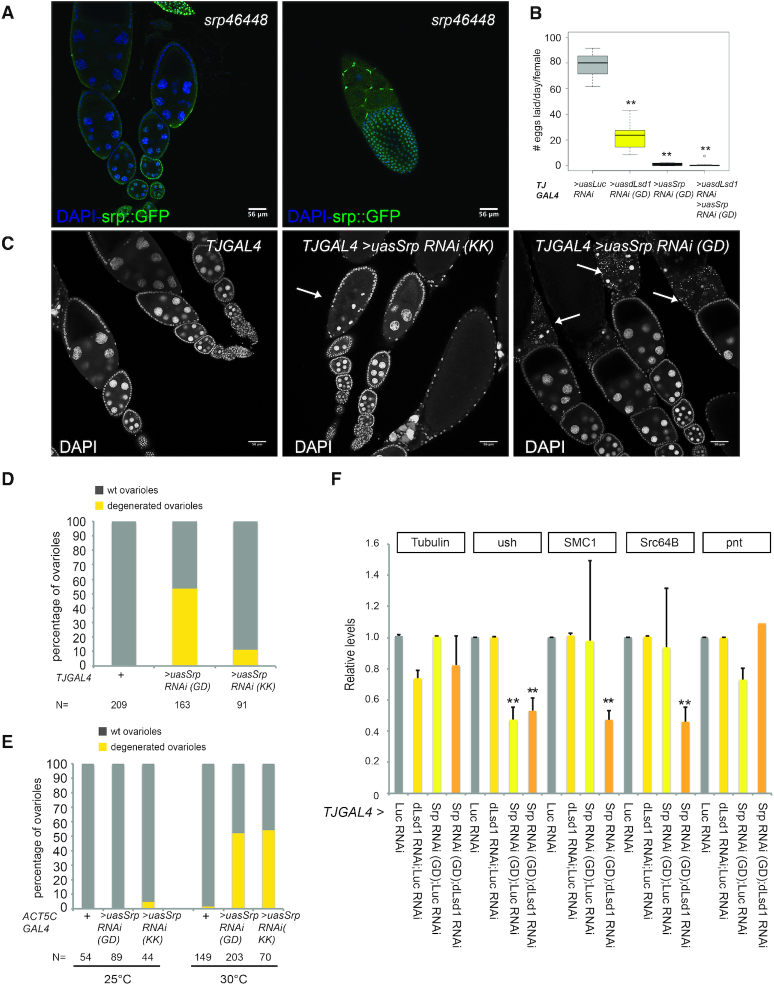
Serpent depletion results in mid-oogenesis defects. (A) Serpent::GFP is detected both in follicle and in nurse cells. Ovarioles of srp46448 flies carrying GFP tagged FlyFOS srp were co-stained for GFP (green), and DAPI (blue). (B) Flies expressing srp RNAi in follicle cells using the Traffic Jam GAL4 (TJGAL4) driver have severe egg laying defects. The numbers of eggs laid per day per female of the indicated genotypes are shown. 10 flies were individually examined for each of the indicated genotypes. A Welch t.test was performed to indicate significance (**P < 0.01). (C) Srp depletion by RNAi using the Traffic-Jam-GAL4 driver results in mid-oogenesis egg chamber degeneration. Ovaries were stained with DAPI. Degenerated egg chambers are indicated by white arrows. (D, E) The cumulative percentage of ovariole phenotypes observed in each of the indicated genotypes. N represents the total number of ovarioles scored for each genotype. (F) RT-qPCR showing the level of a subset of GATA motif containing target transcripts (ush, SMC1, Src64B) in ovary expressing an RNAi against srp and/or dLsd1 driven by the TJ-GAL4 driver. The housekeeping gene Tubulin and pnt, which does not contain the GATA motif are used as controls. A Student's t test was performed to indicate significance (*P < 0.05, **P < 0.01).